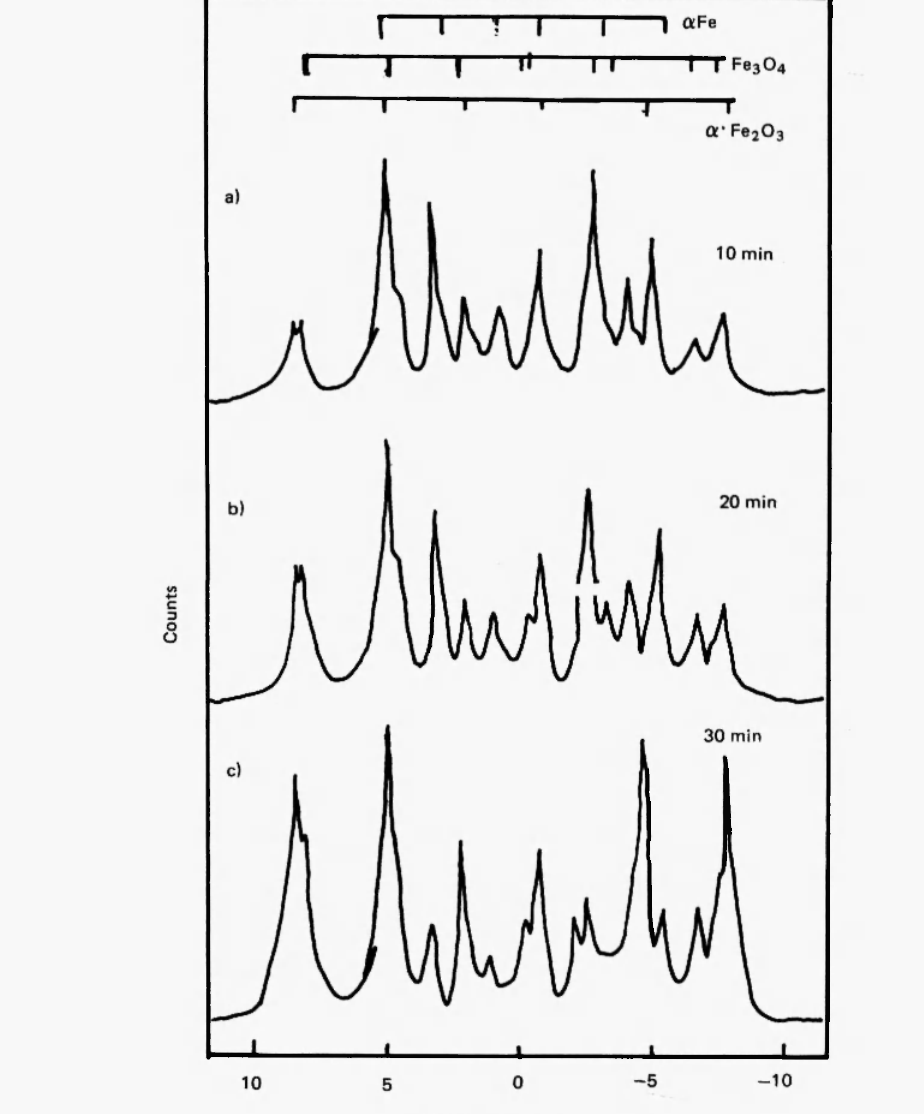
Fig. 13. CEM spectra for an oxidized steel surface heat-treated at 450°C (cited from ref.